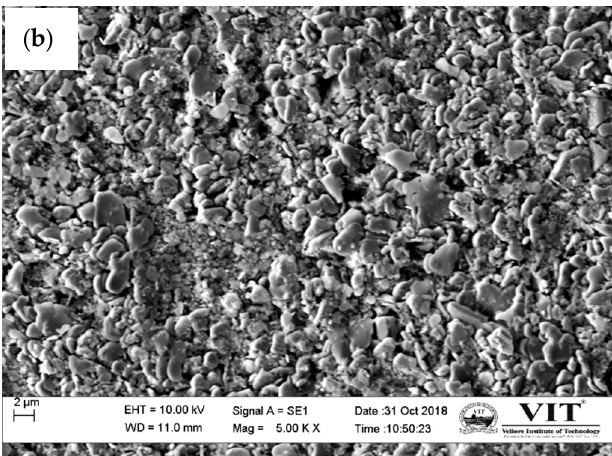
Table 2. Elemental analysis of Ca 3 Co 4 O 9 using EDAX.